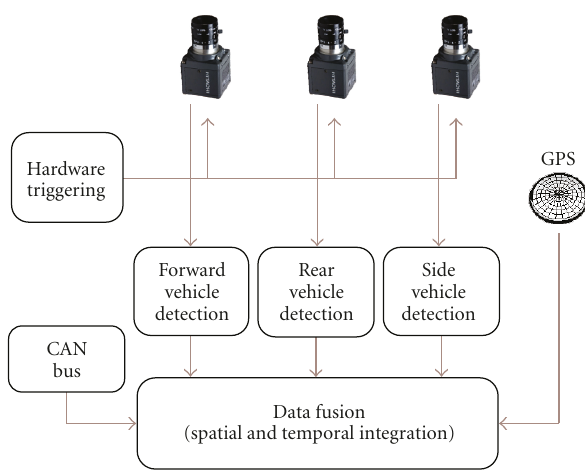
Figure 3: Stages of the vision-based tra ffi c detection system.